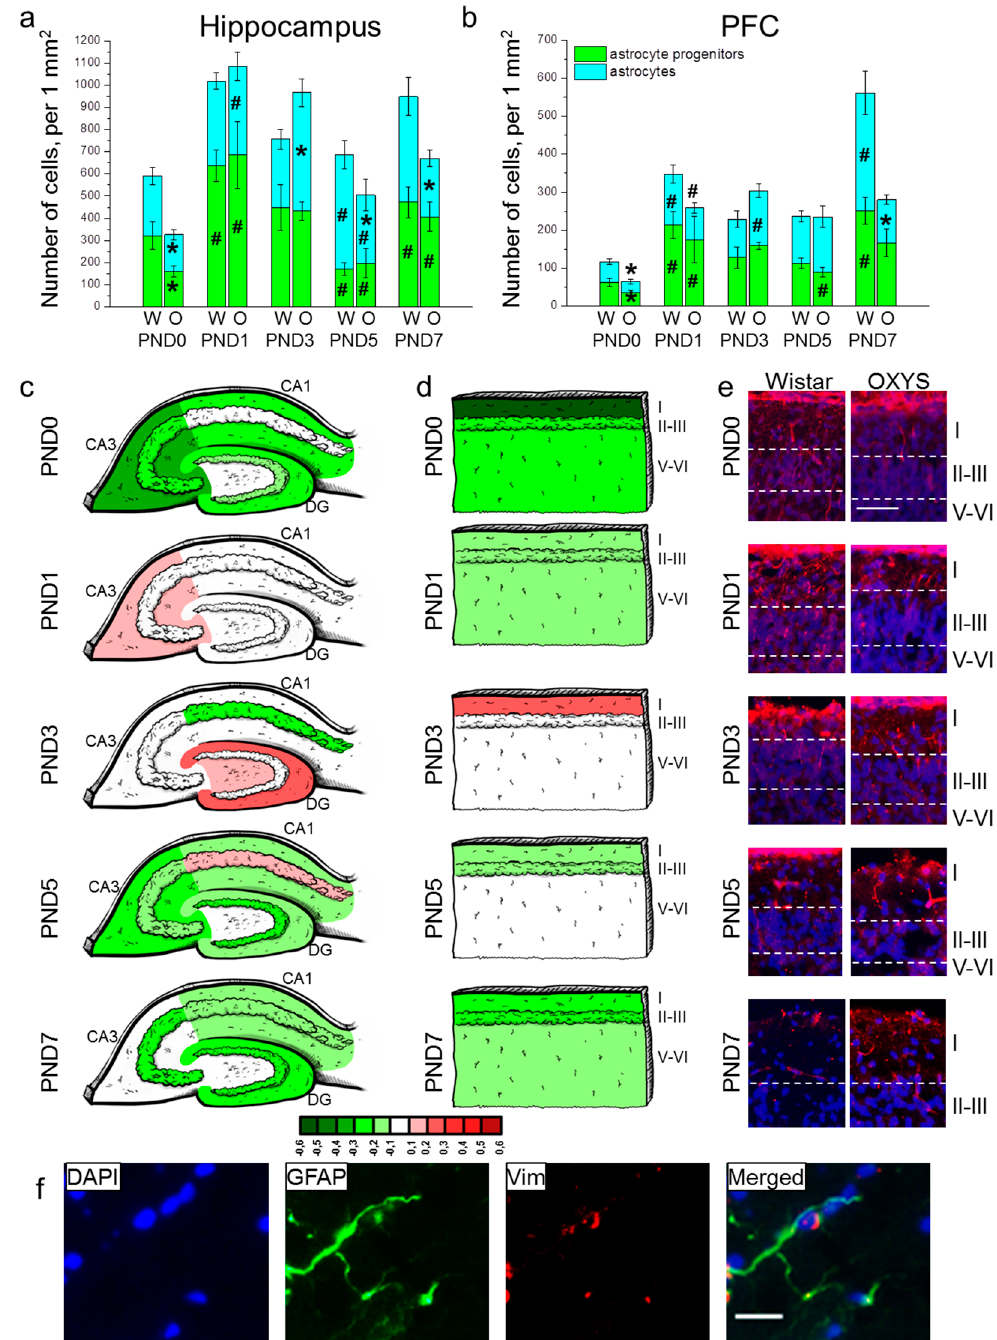
Figure 3. The density of astrocytes and their progenitors in the hippocampus ( a ) and PFC ( b ) of OXYS and Wistar rats during the first postnatal week. Changes in GFAP + cell density in the regions of hippocampus ( c ) and layers of PFC ( d ) of OXYS rats compared to Wistar rats are presented schematically with GFAP + cell density in each region and layer coded as heatmap with lg scale from − 0.6 to 0.6. ( e ) Vimentin (red)-positive processes of radial glia in the PFC of Wistar and OXYS rats; the scale bar is 50 µ m. ( f ) A representative image of GFAP (green)- and vimentin (red)-positive cells in the hippocampus of a Wistar rat at PND7; the scale bar is 20 µ m. DAPI (blue) indicates cell nuclei ( e , f ). W: Wistar; O: OXYS; I: cortical layer I; II–III: cortical layers II–III; V-VI: cortical layers V–VI; Vim: vimentin. The data ( a , b ) are presented as mean ± SEM; * p < 0.05 for differences between the strains; # p < 0.05 for differences from a previous time point. For distributions of astrocytes and their progenitors throughout the regions of the hippocampus and cortical layers, see Table